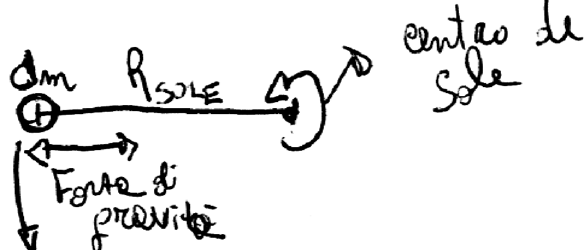
2. Student ’ s sketch of the forces acting on a star ’ s small volume element. Translation of Italian text, from left to right: Gravitational force, R , center of the Sun. sun